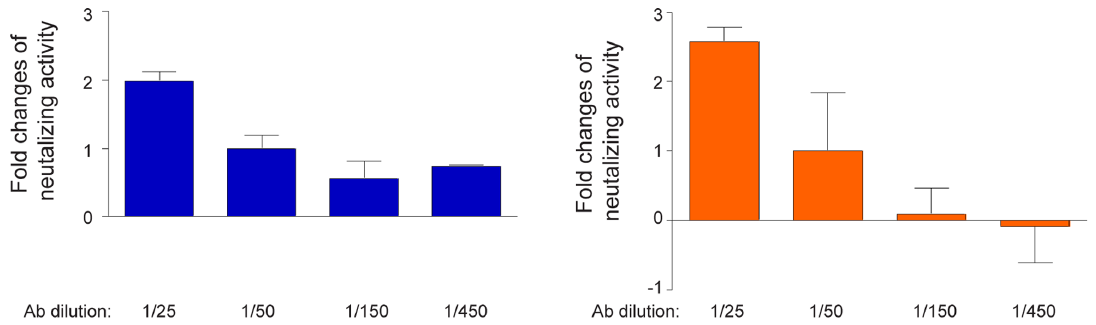
Figure 3. Human antisera neutralizes HCVcc in a dose-dependent fashion. Serum of volunteer 5 was tested for neutralization activity in various doses against 1a (H77C, blue) or 2a (J6, orange) chimeric HCVcc. Sera at indicated dilution were incubated with 100 TCID50 of HCVcc. The level of infection was monitored after staining using NS5A antibodies. Results of an experiment preformed in triplicates are shown. Fold changes of neutralization activity is shown compared to serum using at 1 in 50 dilution.